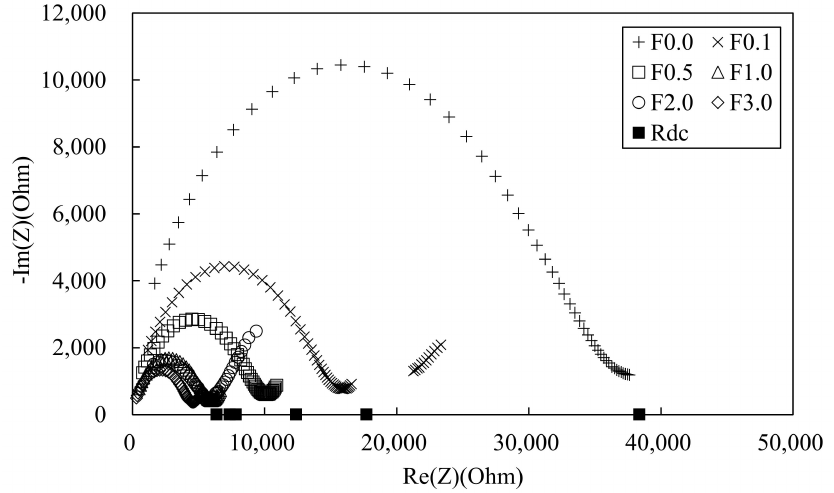
Figure 10. Experimental Nyquist plot for 100 MPa-HPFRCC with (a) 0.1%, (b) 0.5%, (c) 1.0%, (d) 2.0%, and (e) 3.0% steel fiber (volume